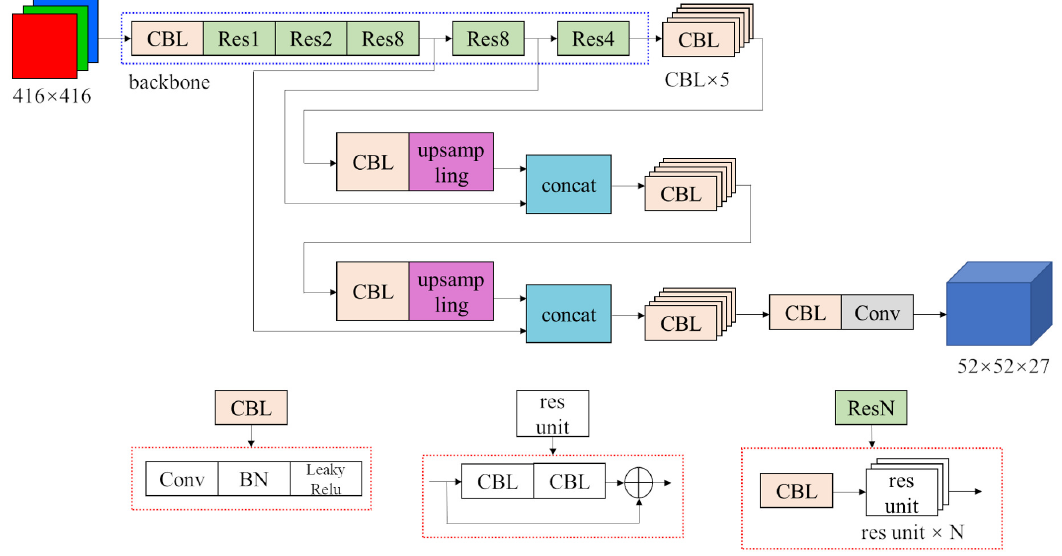
Figure 3. Structure of improved YOLOv3 network.